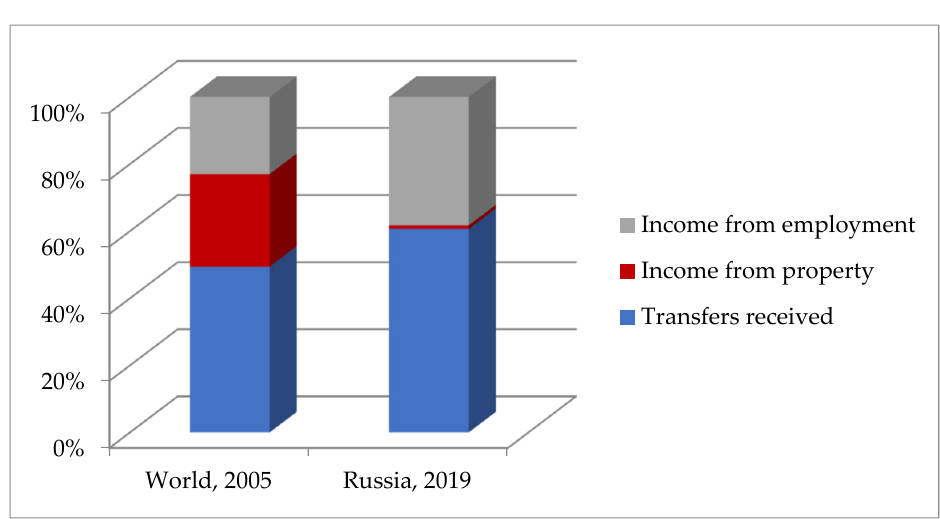
Figure 6. Income structure of the elderly population.